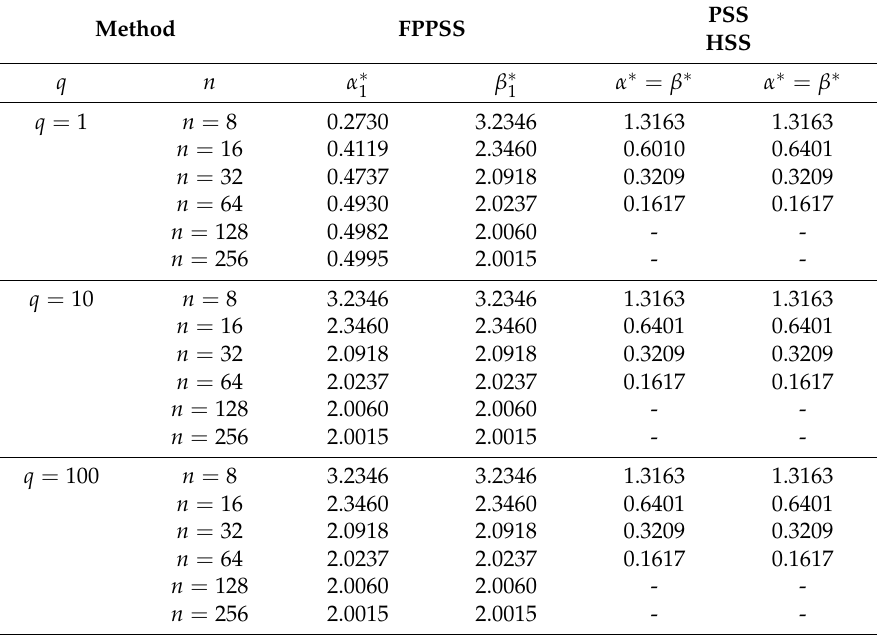
Table 6. The practical optimal value for FPPSS, PSS, and HSS for Example